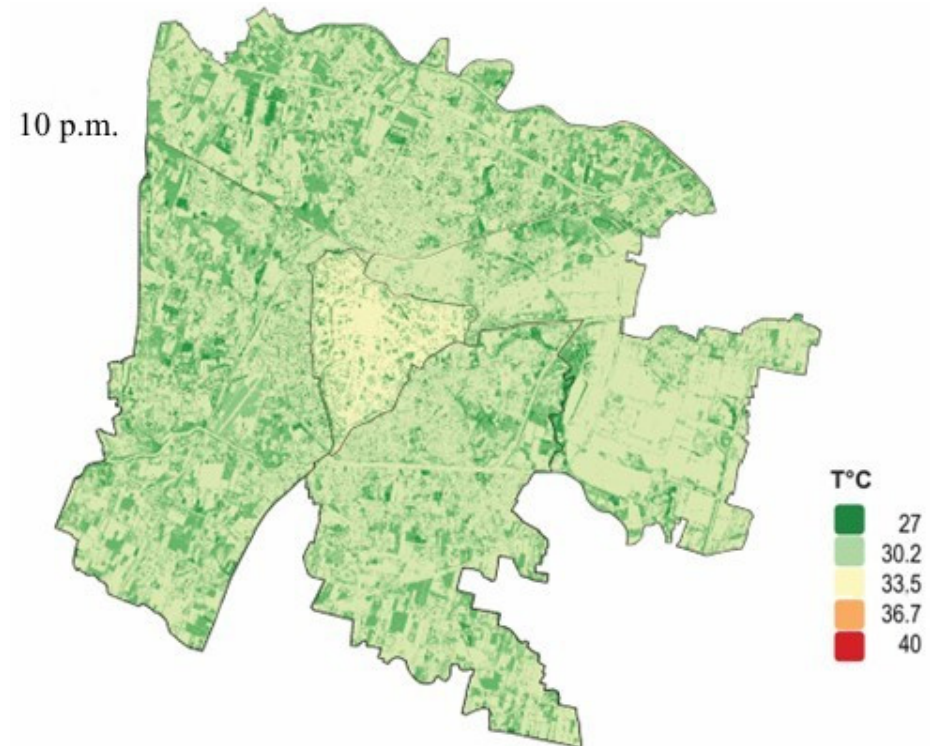
Figure 5. Simulated temperature distribution in the 10 m × 10 m units in the nighttime at 10 p.m. (28 °C at the reference weather station).